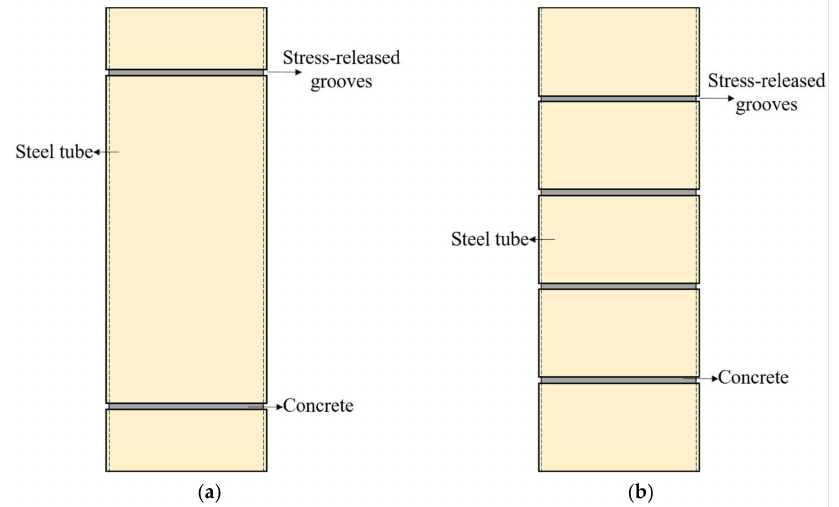
Figure 1. Different kinds of concepts of concrete-filled stress-released steel tubes. ( a ) Steel-tubed concrete columns ( b ) Concrete-filled grooved steel composite